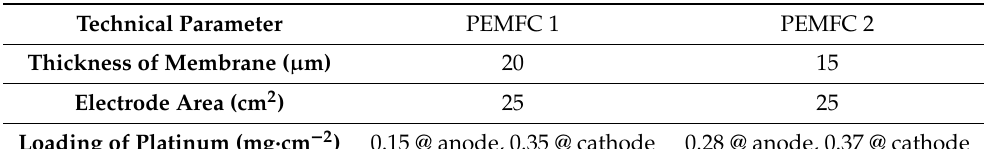
Table 9. Technical details of two